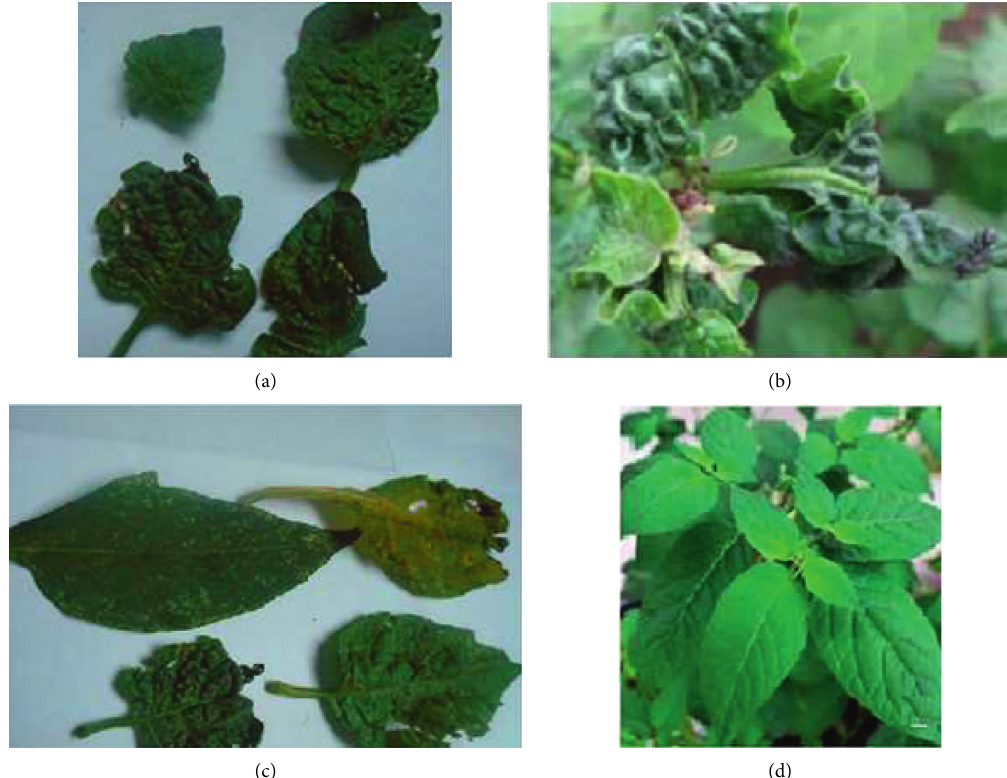
Figure 1: ((a)–(d)) Leaf viral-like symptoms in African nightshade observed in the field. (a) Leaf rugosity. (b) Leaf curling. (c) Leaf malformations. (d) A healthy African nightshade plant.